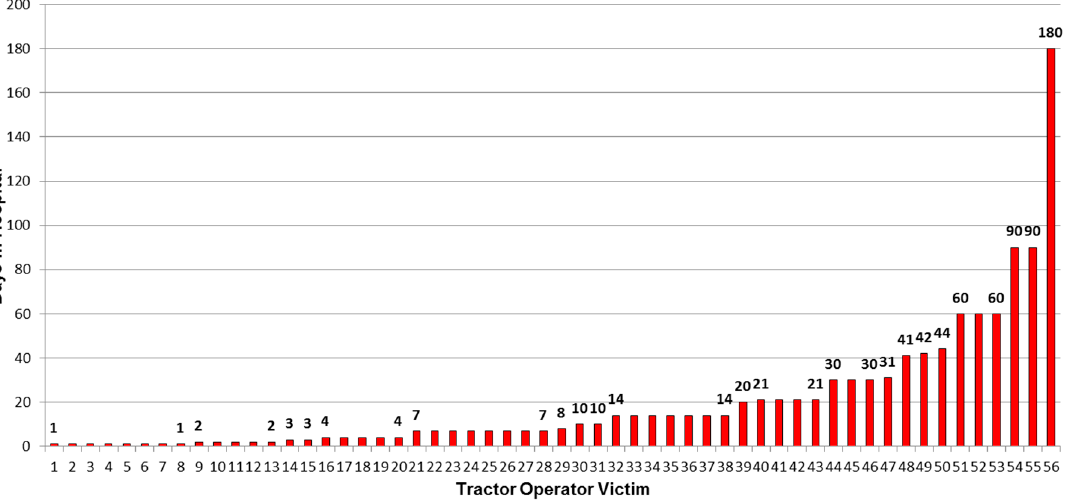
Figure 6. Age of seriously injured operator in an overturns of non-ROPS tractors in Kentucky, 1960–2002, n = 60. Eleven farmers were reported to have sustained permanently disabling injuries that resulted from overturns of non-ROPS tractors. See Table 6. Six of the 11 recovered sufficiently to resume farm work. The reported disabilities for these six farmers included broken ankle, knee, rib, and shoulder bones, as well as torn muscles in shoulders and legs. Five of the 11 farmers with permanent disabilities were never again able to perform farm work, and three were never able to do any other type of work. Of three fully-disabled farmers, one had a crushed chest; and one had injuries that required walking with a cane. The injury description for the third farmer was unknown. None of these fully-disabled farmers required special care typical of that provided by nursing homes. Excluding eight farmers whose permanent disabilities prevented them from performing farm work or other work, the days of farm work lost were known for 48 farmers. These 48 farmers lost a total of at least 6742 farm work days with a mean of at least 140.46 days each (SD = 133.24) with a median of 90 days. Days of farm work lost are strongly skewed to the right, which suggests that non-ROPS tractor overturns result in high injury severity rates as shown in Figure 7.